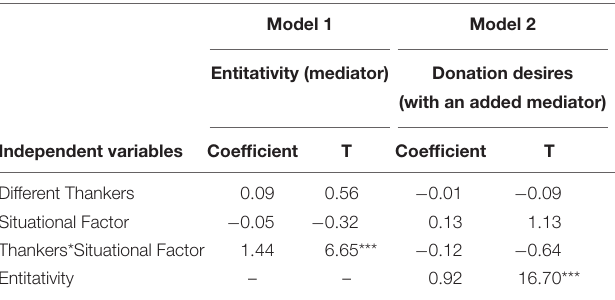
TABLE 2 | Study 3: moderating role of a situational